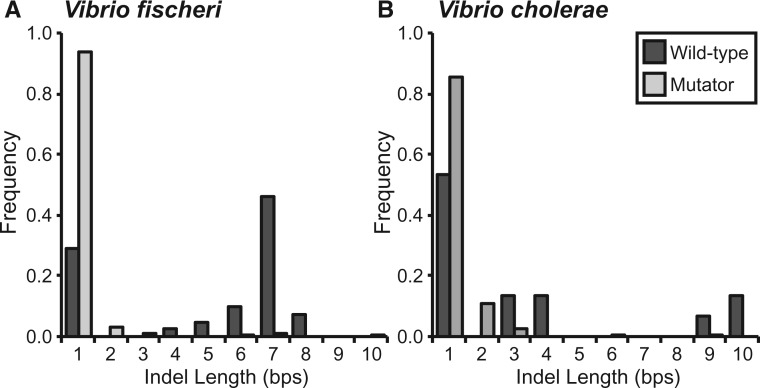
Relative frequency of insertion–deletion mutations (indels) of different lengths observed in the wild-type (wt) and mismatch repair deficient (mut) strains of Vibrio fischeri (A) and Vibrio cholerae (B). Note that the overall indel rates of Vf-mut and Vc-mut are 102- and 142-fold higher than the wild-type rates, respectively, but it is the relative frequencies of different indel lengths that are shown here. The increase in the number of single-nucleotide indels in mutator lines is significant (Vf-mut: χ2 = 5.460 • 103, d.f. = 1, P < 0.0001; Vc-mut: χ2 = 2.567 • 103, d.f. = 1, P < 0.0001).